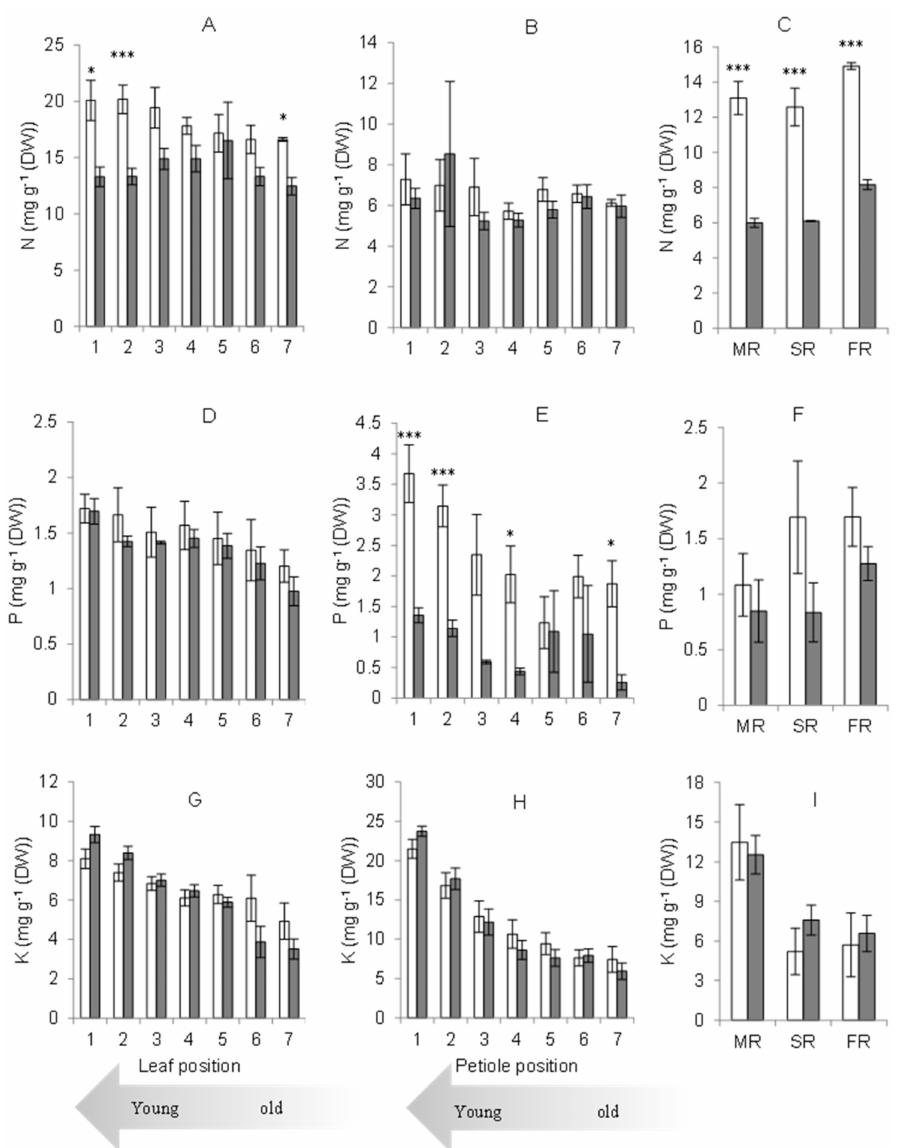
Figure 4. N, P, and K concentration in leaflets ( A , D , G ), petioles ( B , E , H ), and roots (MR: Main